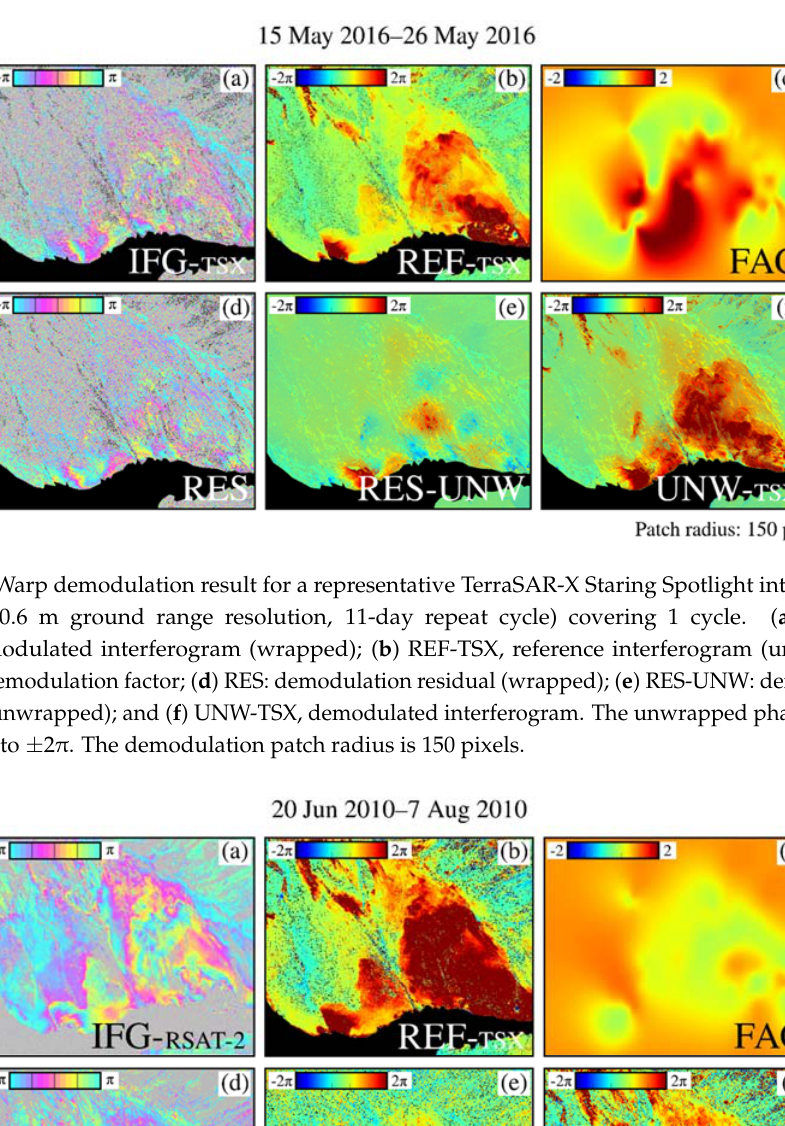
Figure 7. ( a – d ) Standard MCF unwrapping results of four test interferograms (( a ) ERS, ( b ) ALOS ‐ 1, ( c ) RADARSAT ‐ 2, and ( d ) TerraSAR ‐ X Staring Spotlight) over the Fels Glacier Slide. ( e – h ) Warp demodulation results for the same test sites for direct comparison (same as subfigures ( f ) in Figures 8–11). The unwrapped phase is clipped to (cid:3399)2π .